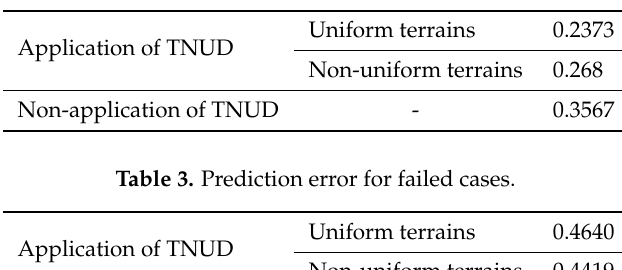
Table 2. Prediction error.